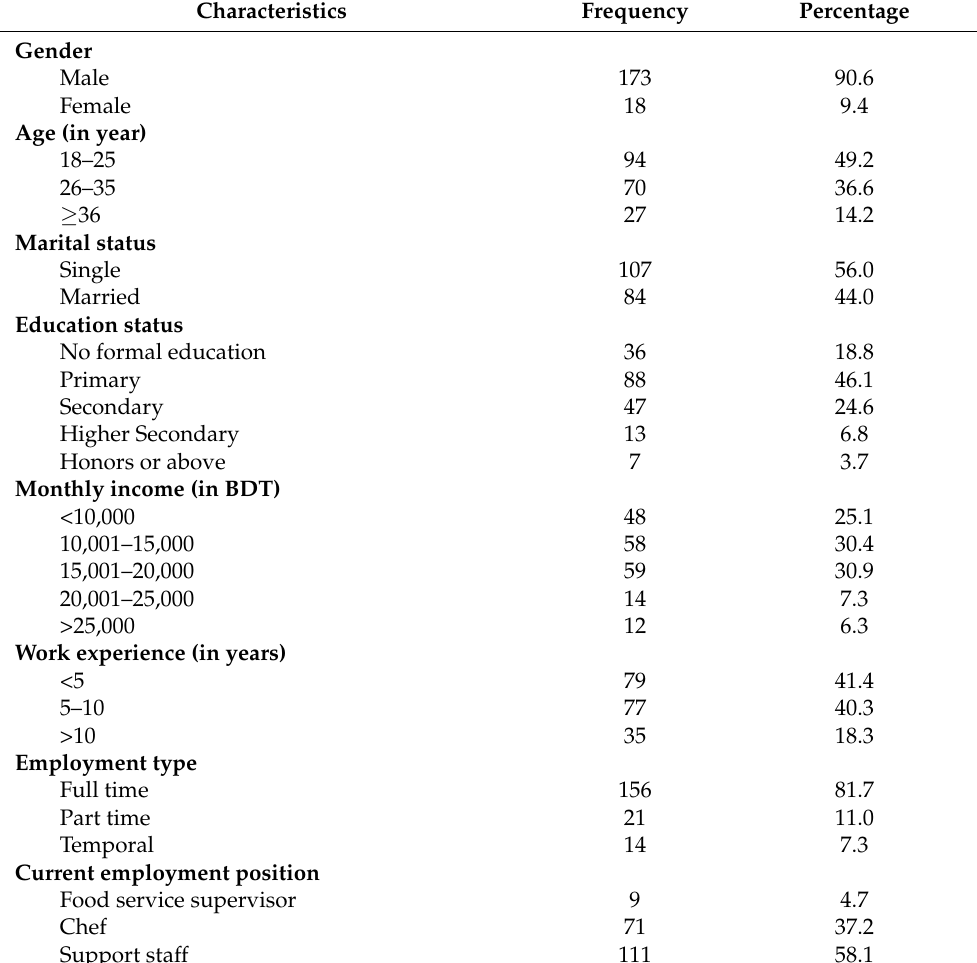
Table 1. Sociodemographic and employment characteristics of study participants (N =